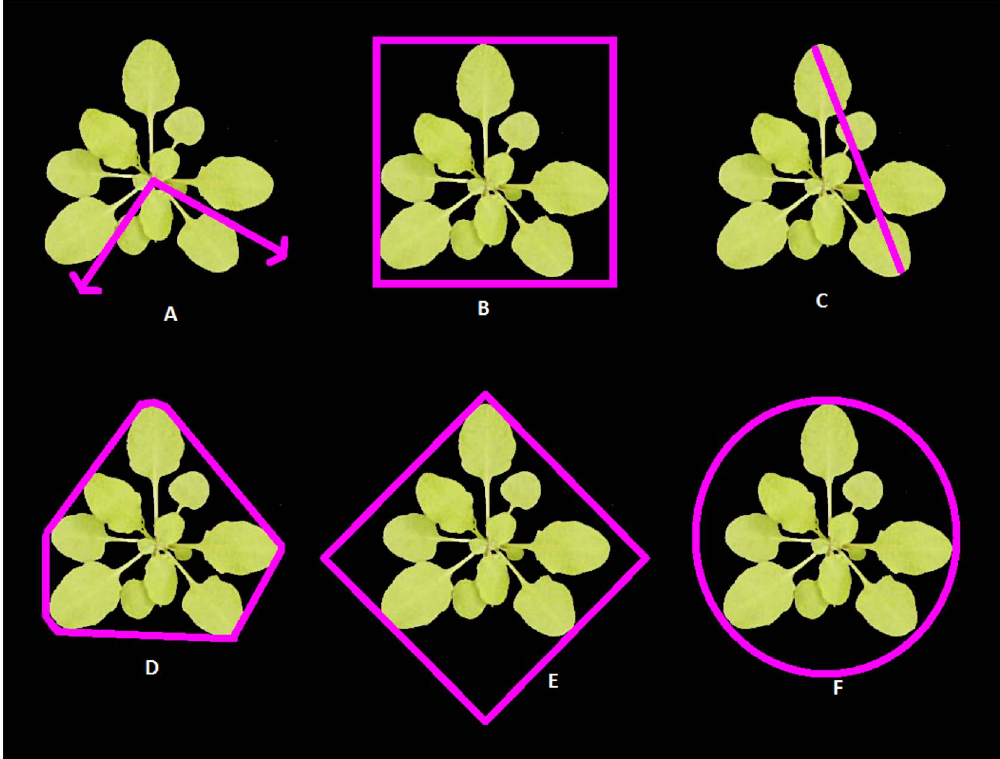
Figure 2. Example features extracted from one plant of EDi-0. (A) normsmallpax and lormlargepax, (B) vrectsizex and vrectsizey, (C) maxdiam, (D) outline of convex hull, from which convhullcirc and convhullarea are determined (E) minrectarea, (F) mincirclediam.